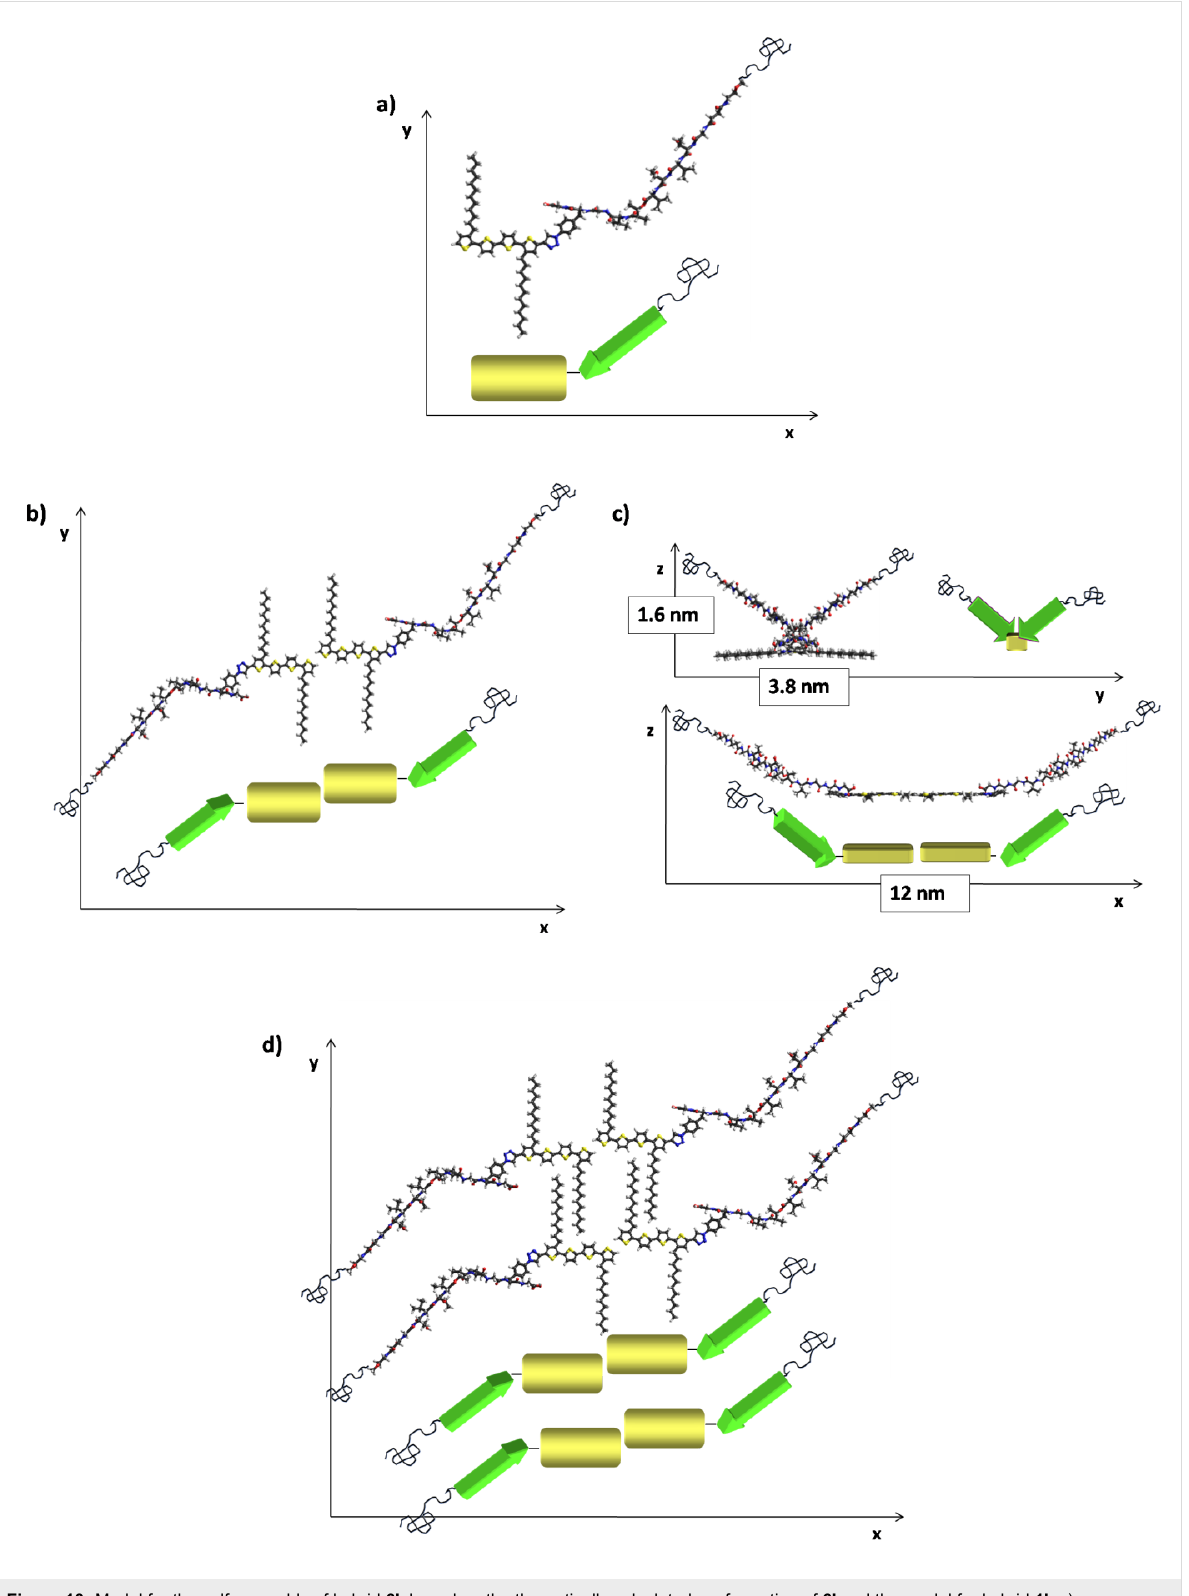
Figure 10: Model for the self-assembly of hybrid 6' , based on the theoretically calculated conformation of 6' and the model for hybrid 1' ; a) con- formation of 6' ; b) and c) depiction of dimers of 6' in the three Cartesian directions; c) proposed ensemble of four molecules of 6'